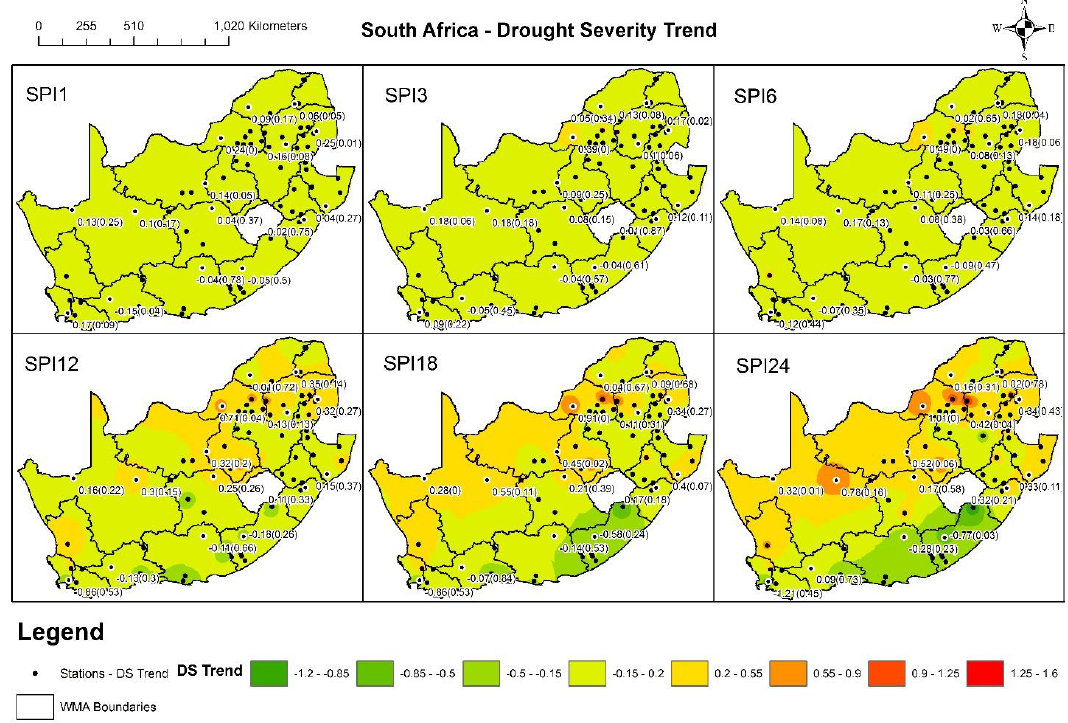
Figure 7. Spatial patterns of temporal trends in drought severity derived from SPI-1, SPI-3, SPI-6, SPI-12, SPI-18, and SPI-24 accumulation periods. The significance levels are given in brackets.